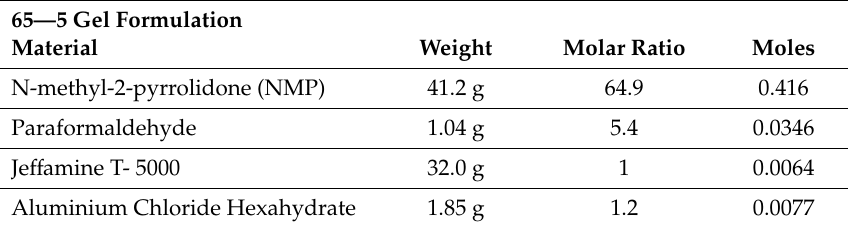
Table 1. Gel and liquid formulations with N -methyl pyrrolidone